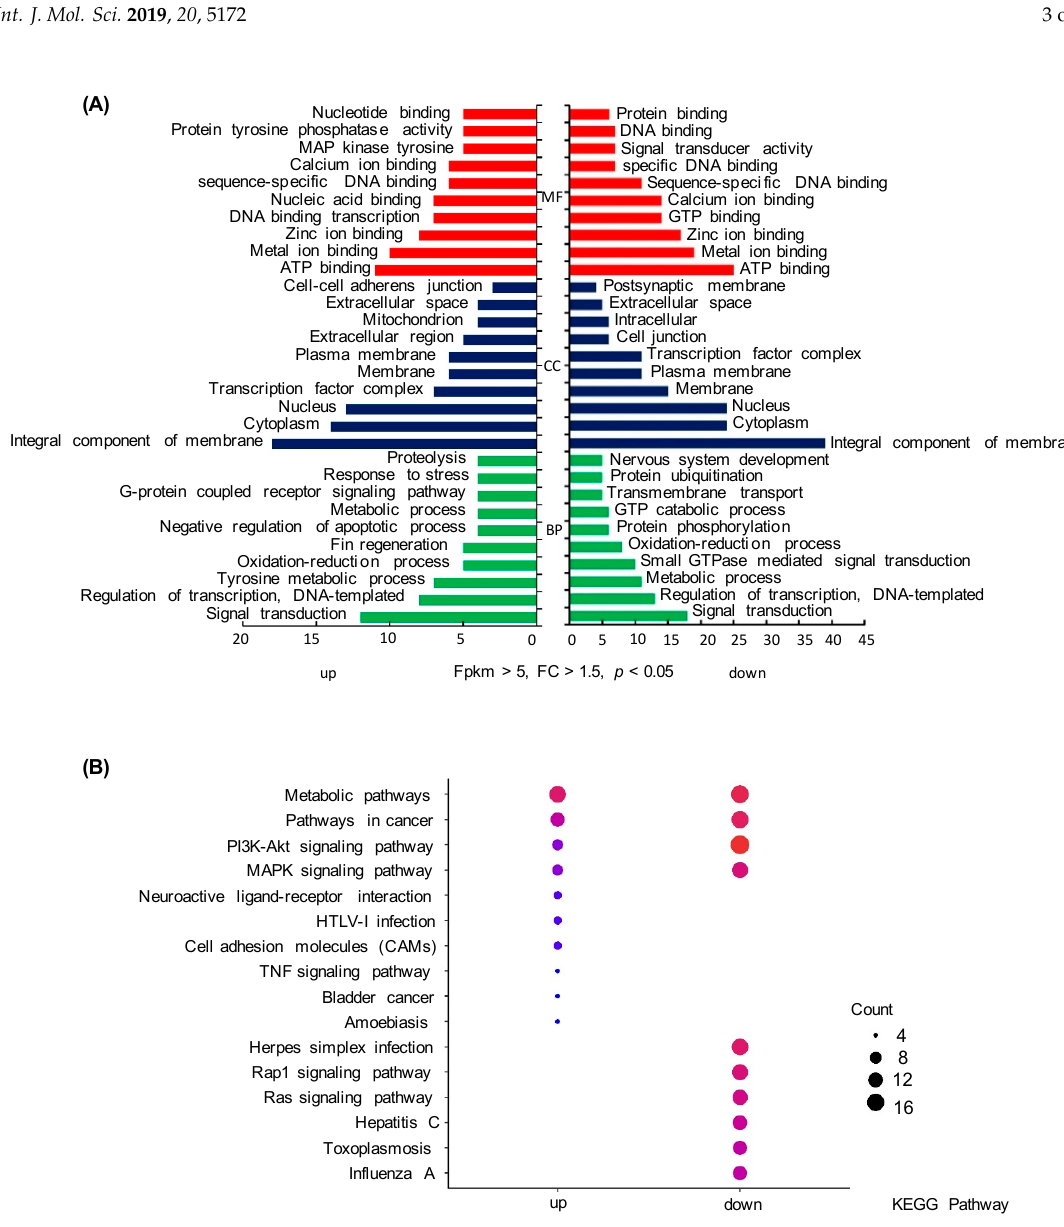
Figure 1. Gene ontology (GO) and Kyoto Encyclopedia of Genes and Genomes (KEGG) analysis. ( A ) GO classification of the assembled differential expression genes (DEGs) of grass carp pituitary cells into molecular function, biological function, cellular component. ( B ) KEGG pathway enrichment analysis for DEGs in grass carp pituitary. Statistics of the top 10 enriched pathways for DEGs of up and down regulation. Up, up-regulated genes; down, down-regulated genes; count, the number of DEGs.